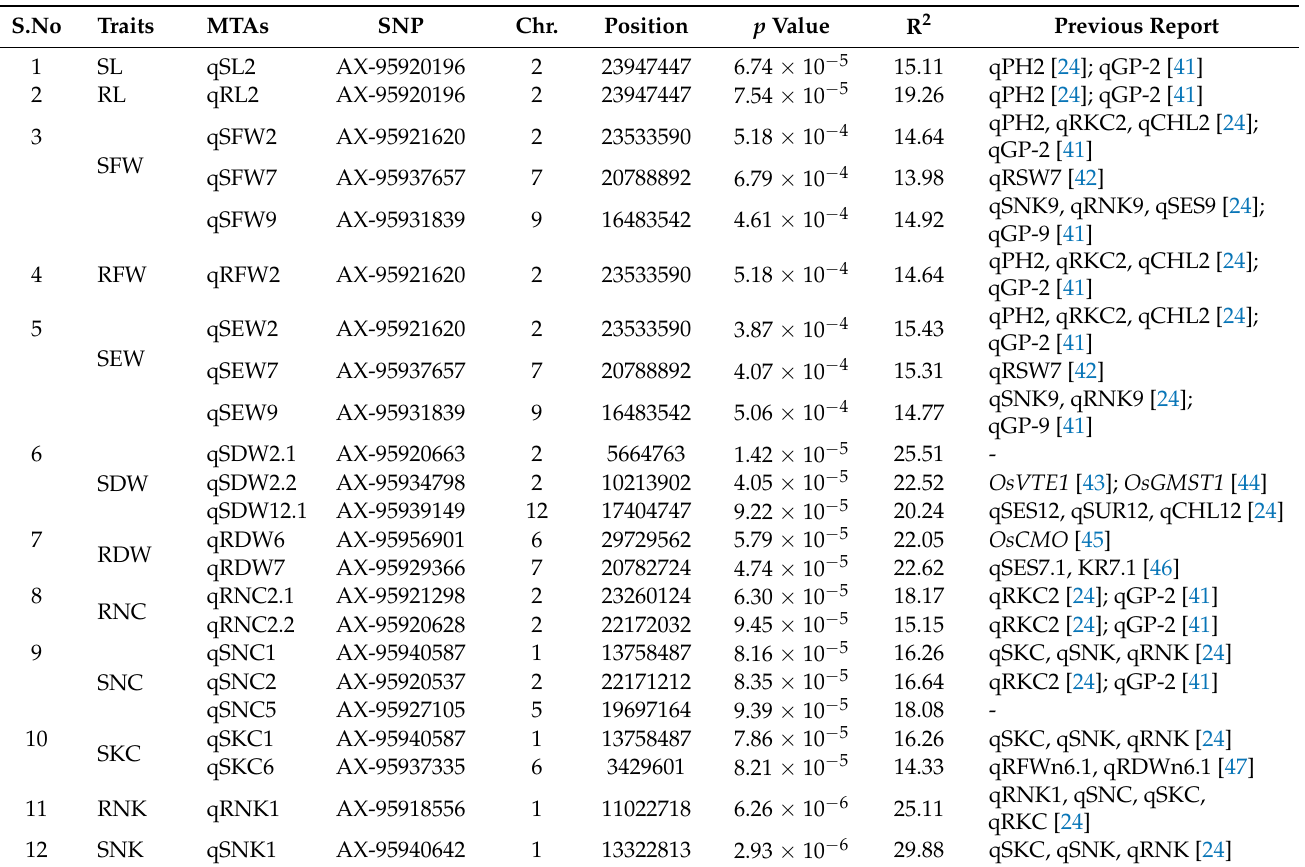
Table 1. Details of the marker-trait associations (MTAs) identified for salt tolerance related traits at seedling stage. S.No